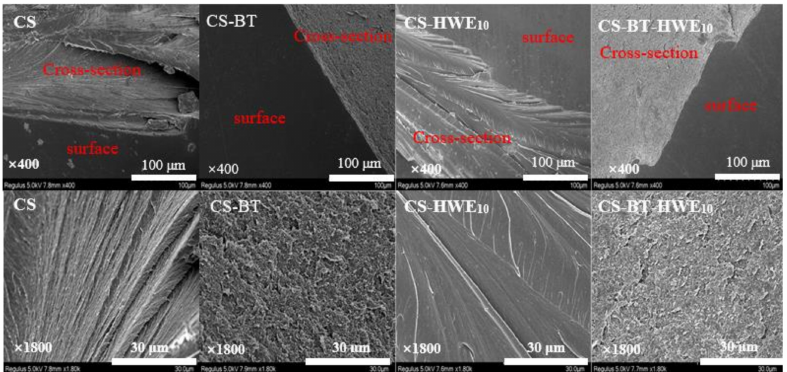
Figure 4. SEM images of composite films prepared from chitosan, BT, and hot water wood extract. The pictures in the first line show the surface and cross-sectional morphology of the films, and the magnified cross-sectional morphology for the corresponding films are in the second line.